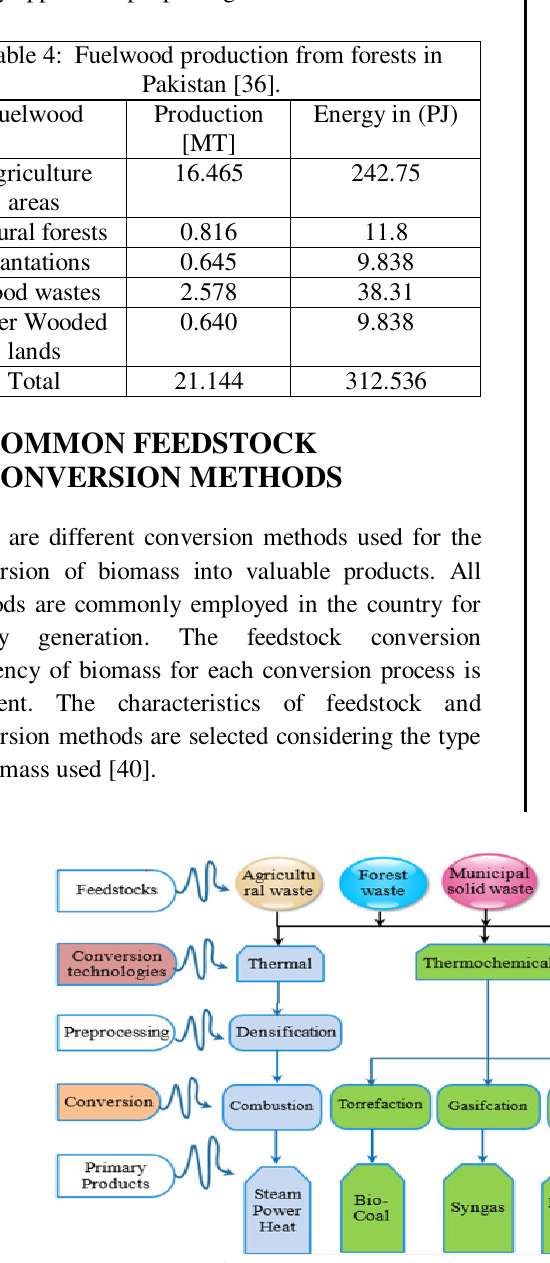
Fig. 10: Energy production routes from wastes and their